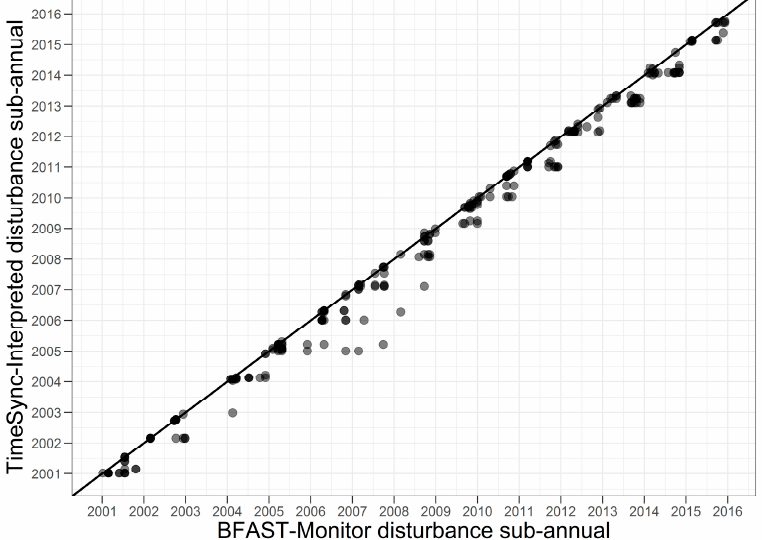
Figure 7. TimeSync-based comparison of sub-annual BFAST Monitor-output disturbance dates against breakpoint dates identified using reference datasets.